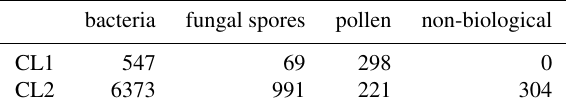
Table 7. Matching matrix for the worst case scenario when using the current data preparation strategy with 9 σ on the data collected in 2008.